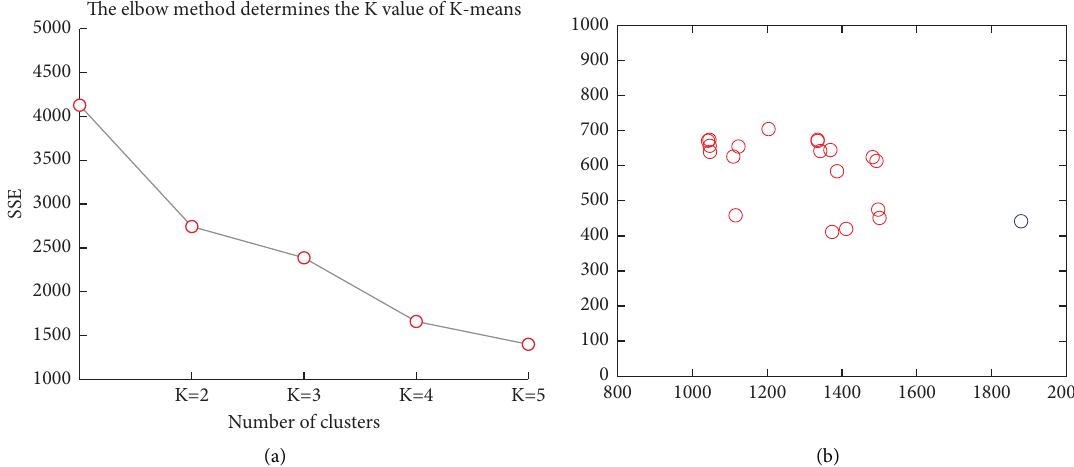
Figure 4: K -means cluster diagram. (a) Determine the value of K . (b) Obstacle points clustering (circles of the same color are divided into one class; red and blue circles belong to two separate classes).